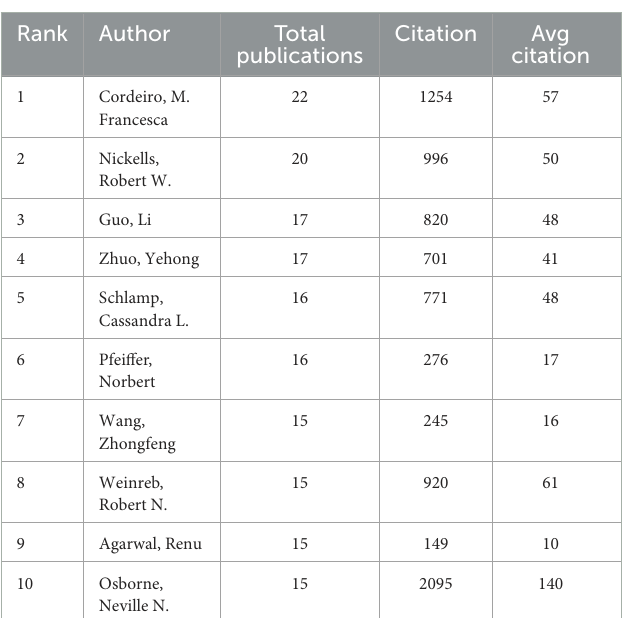
TABLE 5 The top 10 productive